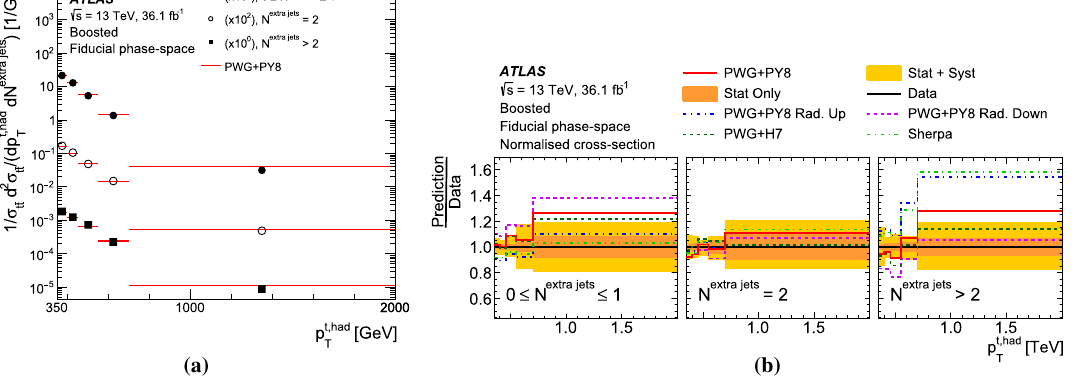
Fig. 50 a Particle-levelnormaliseddifferentialcross-sectionasafunc- tion of the p T of the hadronically decaying top quark in bins of the number of additional jets in the boosted topology compared with the prediction obtained with the Powheg + Pythia8 MC generator. Data